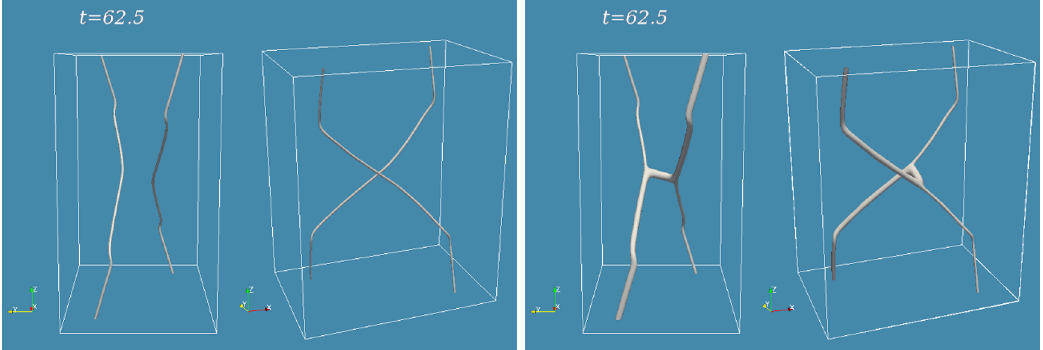
Figure 2 . Collision between a compensated string with ( n 1 ; n 2 ) = (1 ; 2) and an uncompensated string with ( n 1 ; n 2 ) = (1 ; 1) at late times. The left (right) panels show the isosurface with j (cid:30) 1 j = (cid:17) 1 = 2 ( j (cid:30) 2 j = (cid:17) 2 =